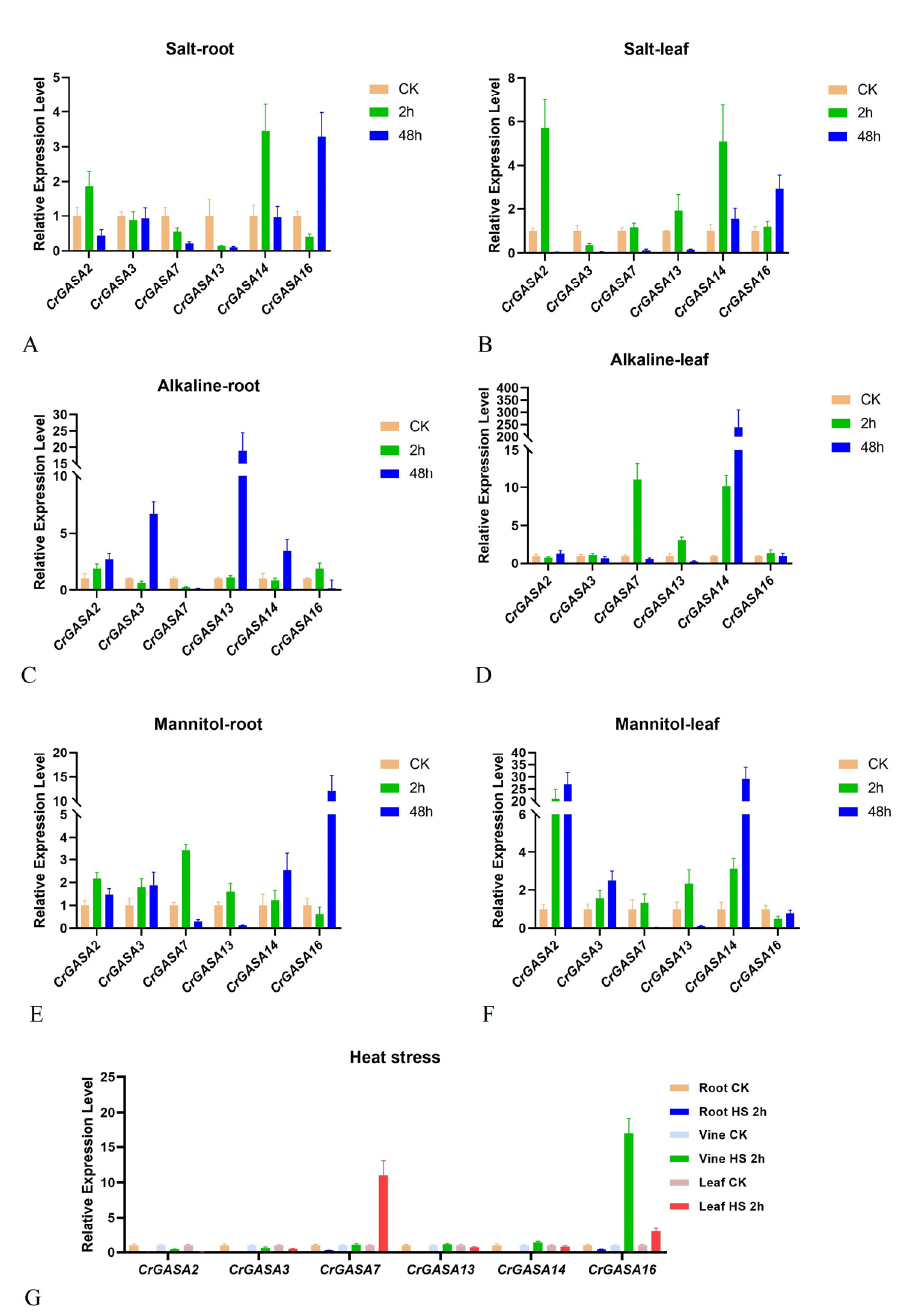
Figure 9. Quantitative RT-PCR detection of the expression levels of the six CrGASA s in C. rosea seedlings responding to different stresses, including 600 mM NaCl, 150 mM NaHCO 3 , 300 mM mannitol, and heat stress (45 °C), for different times (0, 2 h, and 48 h). ( A , B ) Root and leaf samples under 600 mM NaCl treatment; ( C , D ) root and leaf samples under 150 mM NaHCO 3 treatment; ( E , F ) root and leaf samples under 300 mM mannitol treatment; and ( G ) root, vine, and leaf samples under 2 h heat stress challenge. CK: control. Relative expression values were calculated using the 2 −Δ Ct method, with the housekeeping gene CrEF-1 α as a reference gene. Bars show the mean values ± SD of n = 3–4 technical replicates.